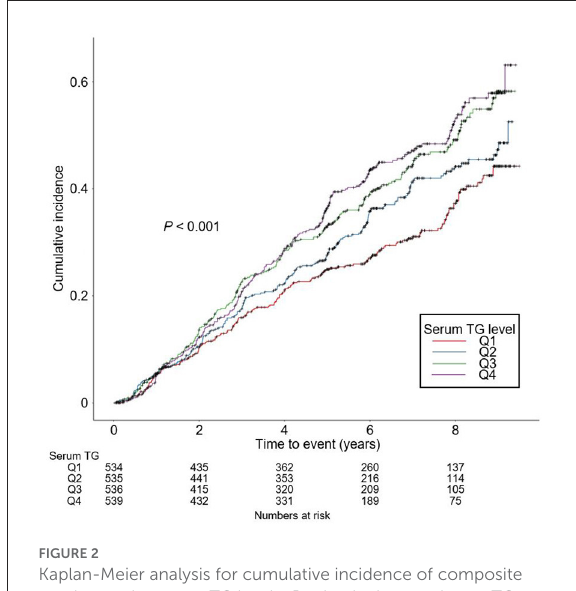
FIGURE2 Kaplan-Meier analysis for cumulative incidence of composite renal event by serum TG levels. P value by Log-rank test. TG, triglycerides; Q1, 1st quintile; Q2, 2nd quintile; Q3, 3rd quintile; Q4, 4th